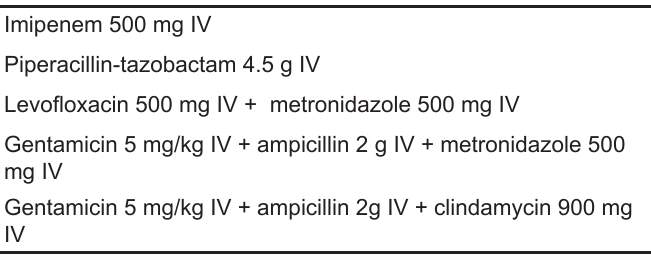
Table 5. Antibiotic regimens for post-abortion infection or